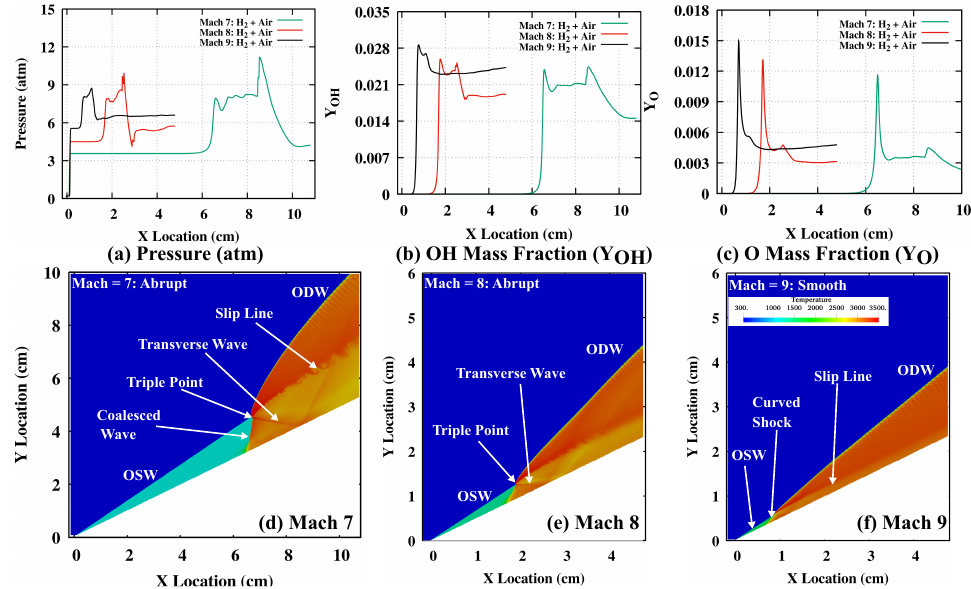
Figure 5. ( a ) Pressure, ( b ) OH Mass Fraction and ( c ) O Mass Fraction variation along the wedge surface and temperature contours for ( d ) Machs 7, ( e ) 8 and ( f ) 9 freestream flows without